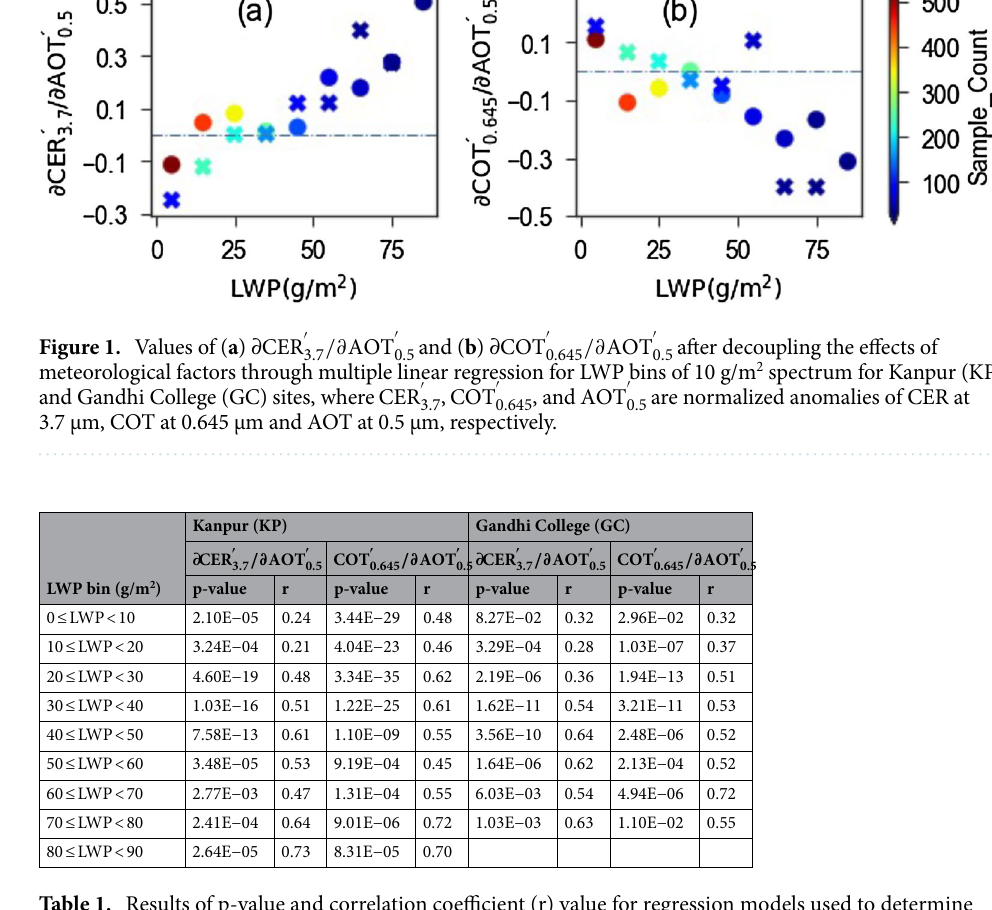
shown in Fig. 1. As 3.7 µm wavelength has a weaker cloud-depth penetration compared to shorter wavelengths (e.g., 1.6, 2.1 µm) used in cloud remote sensing, this wavelength provides information of droplet size for upper cloud layers. Figure 1a suggests that the response of increased AOT on CER (3.7 µm) is different for relatively thin (low LWP) and thick (high LWP) clouds: the thin (LWP < ~ 25 g/m 2 ) and thick (LWP > ~ 25 g/m 2 ) clouds clearly show the negative and positive relationships, respectively. Figure 1a further reveals that the positive relationship becomes stronger with the increase of LWP. On the other hand, as shown in Supplementary Fig. S2, CER corresponding to 1.6 µm, which represents the droplet size for cloud layers deeper than that for 3.7 µm, hardly shows such increase of the strength of positive relationship with the increase of LWP. The p-value and r value for the regression models corresponding to results of Supplementary Fig. S2 are given in Supplementary Table S1. In general, aerosols near the cloud base influence the lower and/or middle cloud layers through direct aerosol-cloud interaction process, and this effect gradually expands towards the cloud top 10,12 . Such difference regarding LWP dependent strength for positive relationship between CER(3.7 µm) and CER(1.6 µm), as noted in Figs. 1a and S2, indicates that the aerosol-cloud interaction process initiated by aerosols below the cloud base can be opposed by the next process occurring near the cloud top (see "Discussion"). Further, by coinciding with Fig. 1a,b suggests the opposite response of increased aerosols on COT with respect to that on CER. For fixed LWP, such opposite response is not surprising as LWP can be approximated as k × COT × CER, where k is a constant term depending on the vertical inhomogeneity of cloud layers 40,41 . In other words, decreased (increased) CER can increase (decrease) cloud droplet concentration to increase (decrease) total cross section area and COT when LWP remains unchanged. Therefore, the positive relationship is associated with not only CER increment, but also COT decrement. Though a large volume of studies discussed CER increment with the increase of aerosols; however, to the best of our knowledge, this consequent response of increased aerosols on COT decrement has not been discussed in detail. The most plausible explanation for such COT decrement along with CER increment is cloud droplet coalescence process. This suggests that cloud droplet coalescence process can cause the positive relationship between CER and aerosol loading.